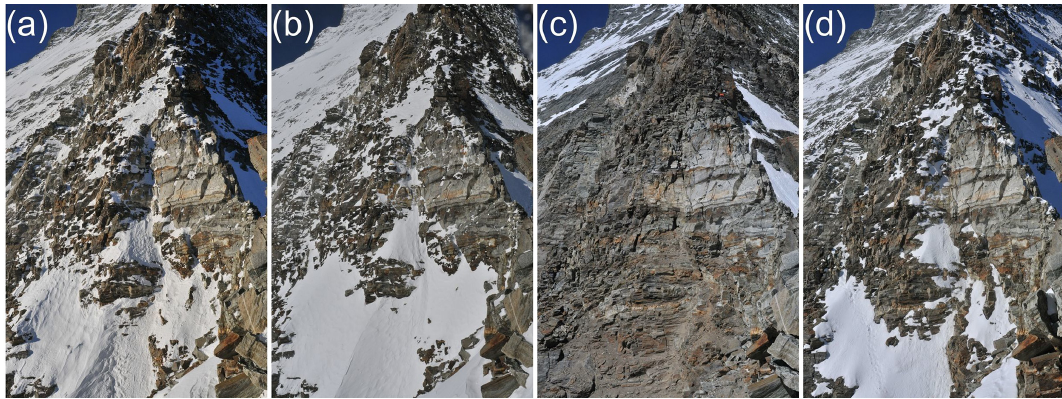
Figure 4. Four webcam pictures, taken in the morning on (a) 1 January 2015, (b) 3 April 2015, (c) 1 July 2015 and (d) 1 October 2015, illustrate the varying snow deposition patterns.